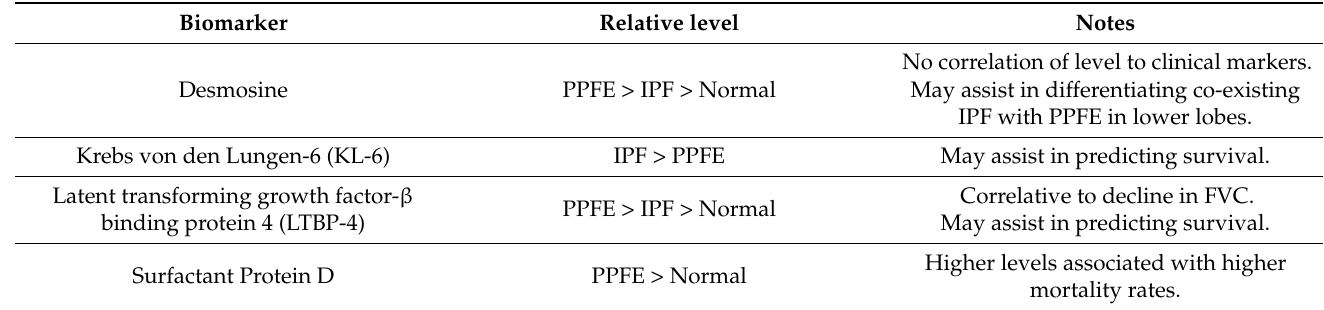
Table 2. Biomarkers for